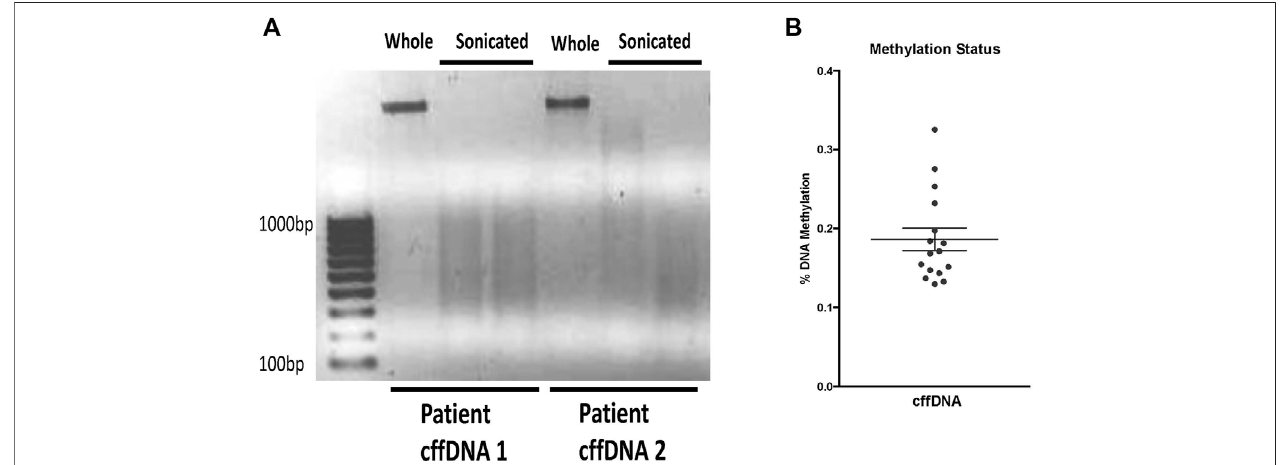
FIGURE 1 | Characterization of fetal DNA fragments isolated from AECs. (A) Ethidium bromide stained gel of DNA either; whole — the cffDNA upon immediate isolation from primary human amnion epithelial cells or, sonicated — cffDNA isolated from primary human amnion epithelial cells but sonicated for 4 min. Two different